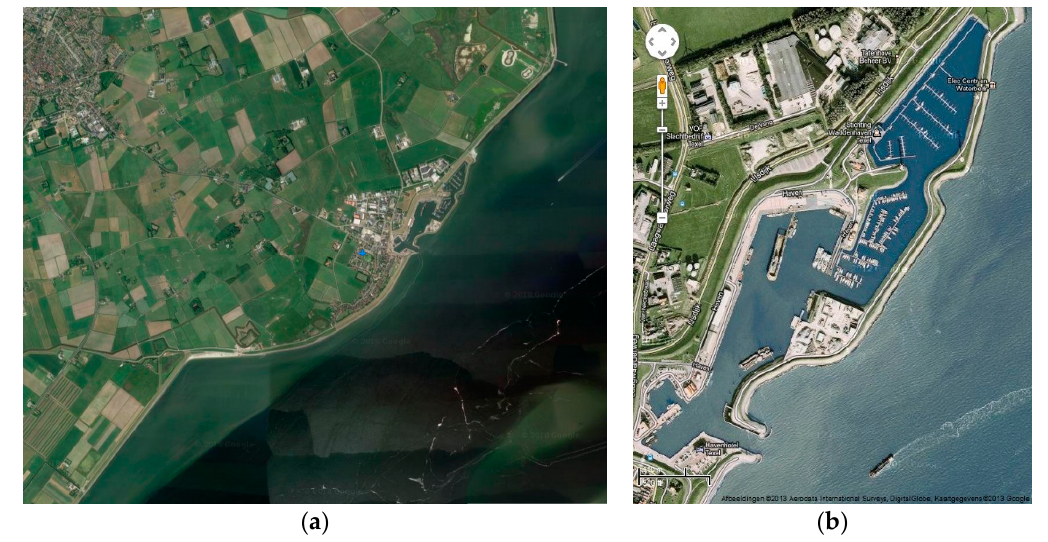
Figure 6. ( a ) High-resolution image of same area; ( b ) Detail of a port in the area.